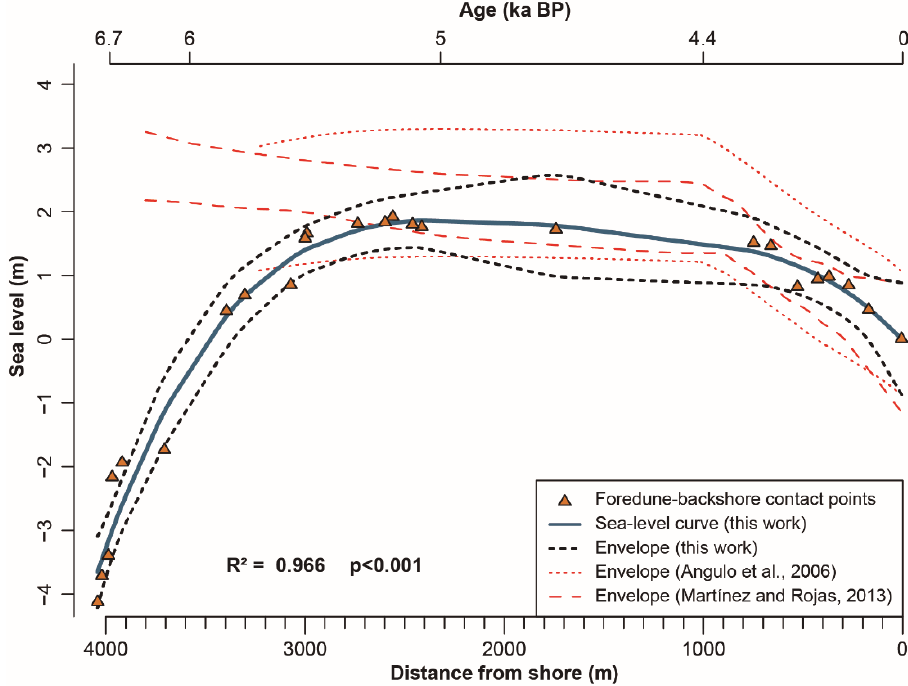
Figure 6. The sea-level curve of the southernmost Brazilian coast, this work, based on 24 foredune- backshore contact points identified by GPR at Arroio do Sal (29°30 ′ S-49°53 ′ W–Figure 5). These paleo sea levels were adjusted to the current mean sea level (MSL). The 5th-order polynomial curve (R 2 = 0.966, p < 0.001) and the envelope (black dashed lines), this work, represent the lower and upper limit of the predicted intervals (CI, 99%). OSL ages are displayed at the superior x-axis. We have also included a modern point at (0, 0) to indicate the present mean sea level. The red dotted and dashed lines represent the envelopes of Imbituba-Laguna [4] and Uruguay [31], respectively. These two envelopes were plotted according to axes Y (sea level altitude) and X (age).